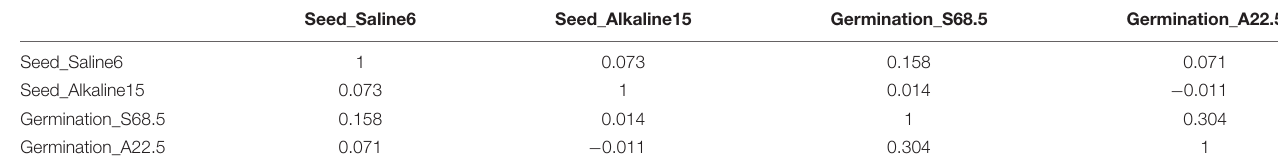
TABLE 6 | Non-significant correlations among tolerances to salt and alkali in seed germination and seed-set across 43 genotypes.